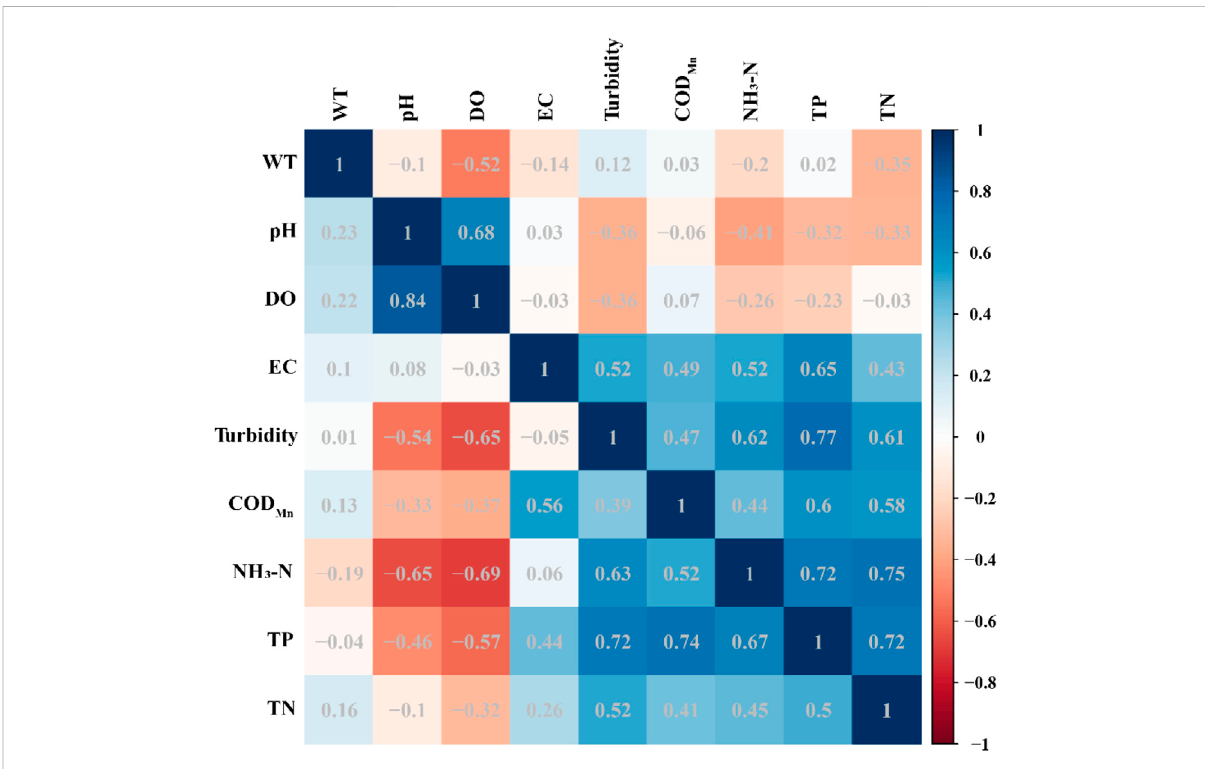
FIGURE 4 Correlation coef fi cients of water quality indicators in the Huaihe River Basin before and after the rainstorm. Note: the upper right corner is the correlation coef fi cients between the water quality indicators before the rainstorm, and the lower left corner is the correlation coef fi cients between the water quality indicators after the